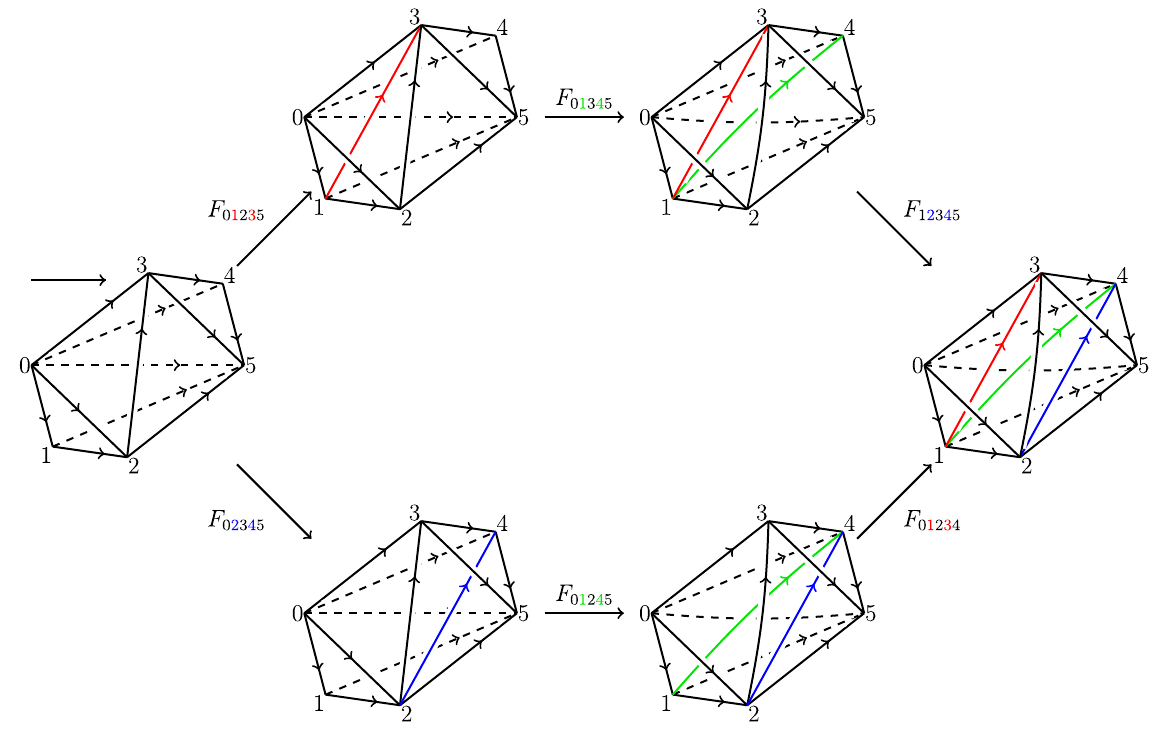
FIG. 20. Fermionic fusion hexagon equation. All of the F moves are of the standard (2-3) move [see Eqs. (40) and (41)]. Colored numbers i and j in the subscript of F indicate that the link h ij i with the same color is added after this F move. All six F moves do not introduce new singular lines and surfaces. There is a global direction from left to right such that the vertex with the smaller number has the earlier